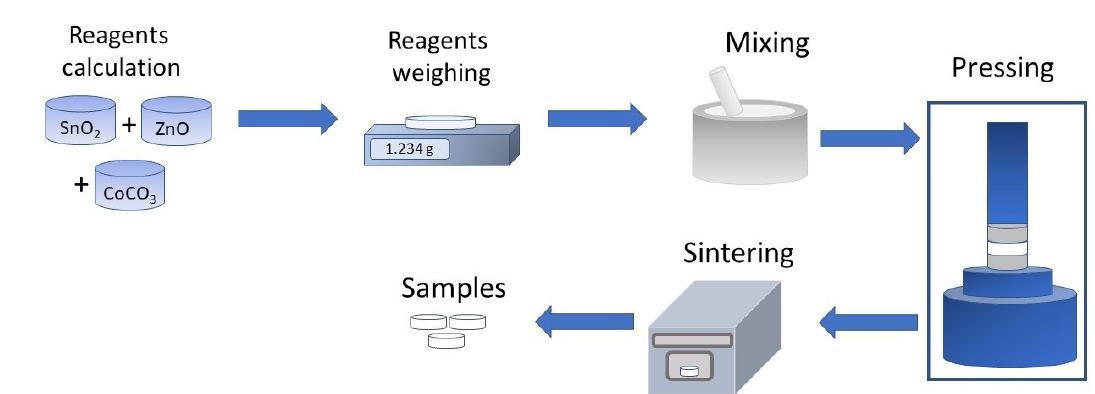
Figure 2. Diagram of the sample preparation